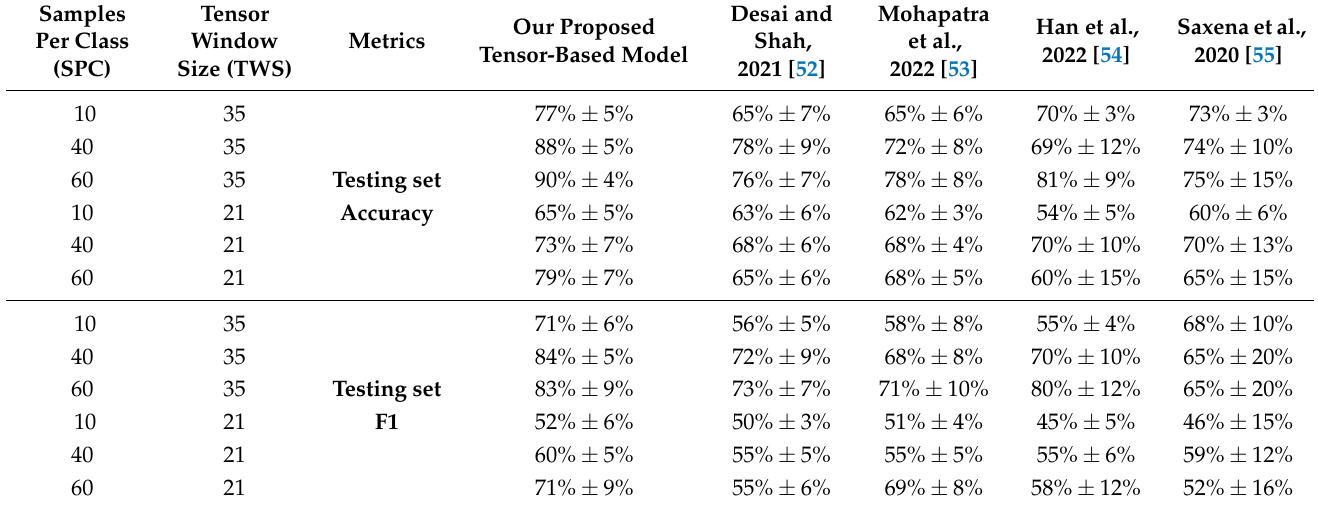
Table 2. Comparison of the performance metrics (accuracy and F1-score) between the proposed approach and state-of-the-art deep learning models for detecting abnormalities in mammograms. Each value represents the mean score achieved for different experimental configurations (SPC and TWS) followed by the 95% confidence